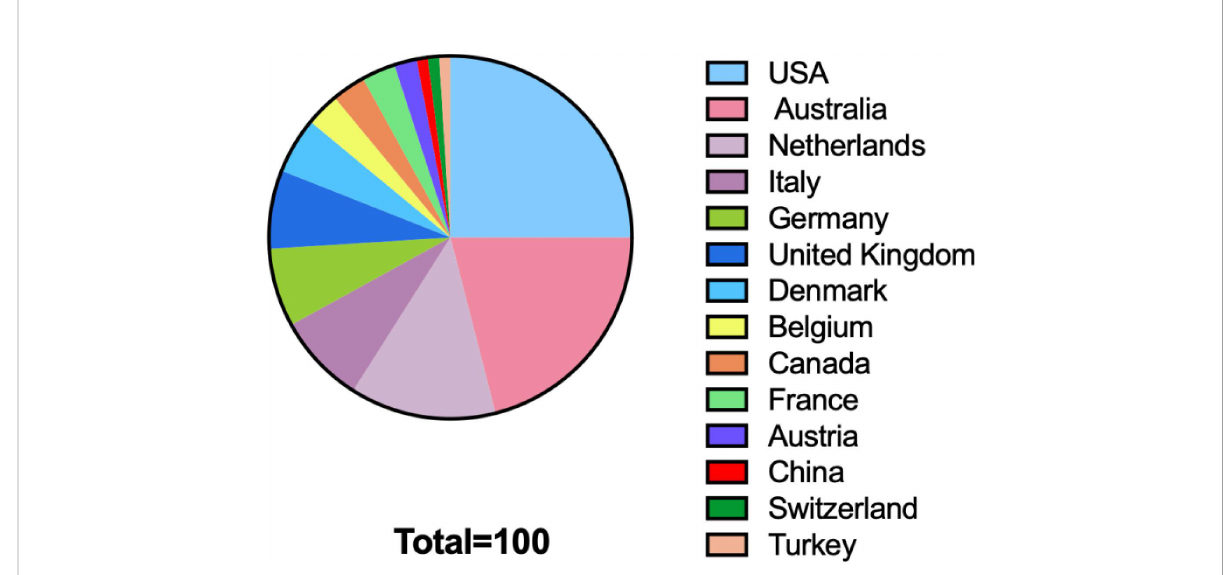
(Figure 3): quality of life, end-of-life symptoms and care,